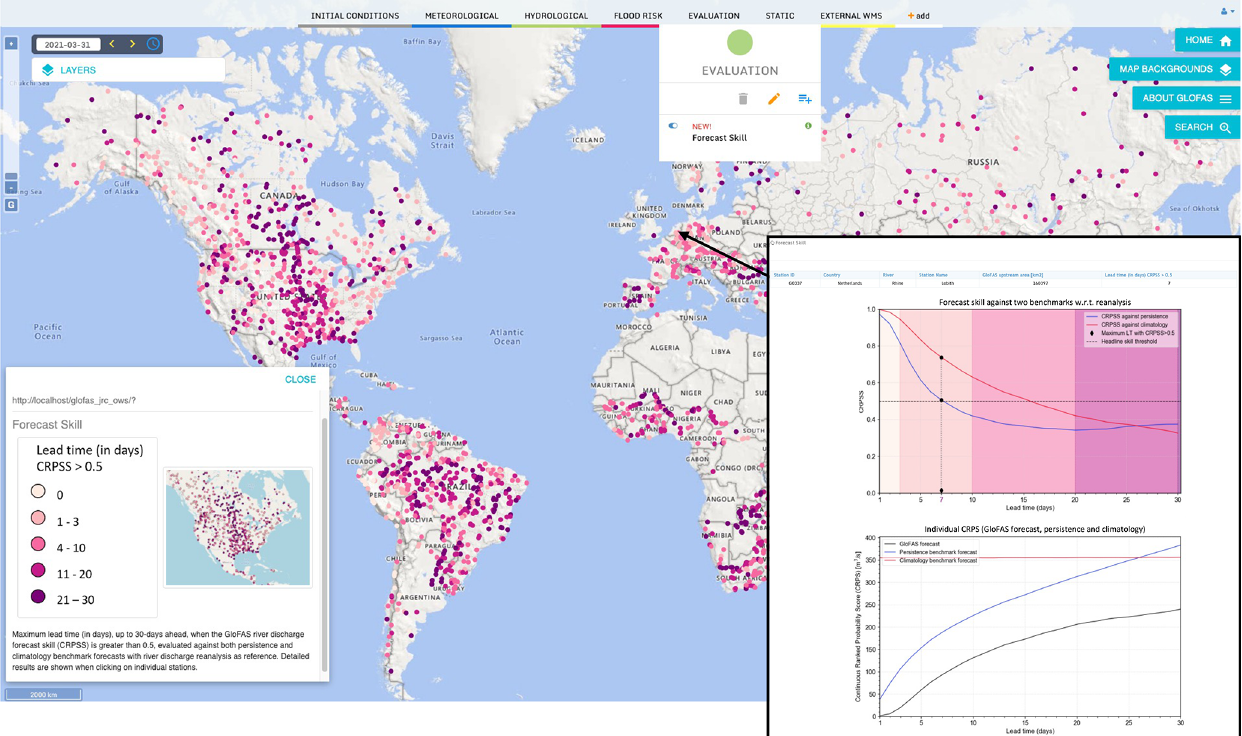
Figure 9. GloFAS 30d forecast skill layer for the headline score available on the GloFAS Web Map Viewer. The headline score is the maximum lead time (in days) the continuous ranked probability skill scores (CRPSS) is greater than a value of 0.5, evaluated against a persistence or climatology benchmark forecast. Clicking on each GloFAS reporting point, a “pop-out” window shows the detailed CRPSS and CRPS across all lead times. An example for the Rhine at Lobith (Netherlands, G0337) is shown in the inset.